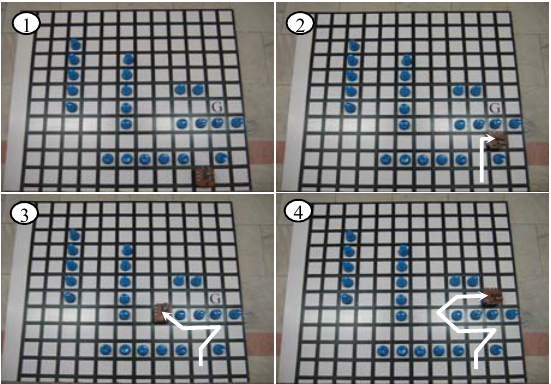
Fig.16. Four snapshots of a single robot test in an environment with convex obstacles. The generated path by the proposed algorithm is shown by white lines.